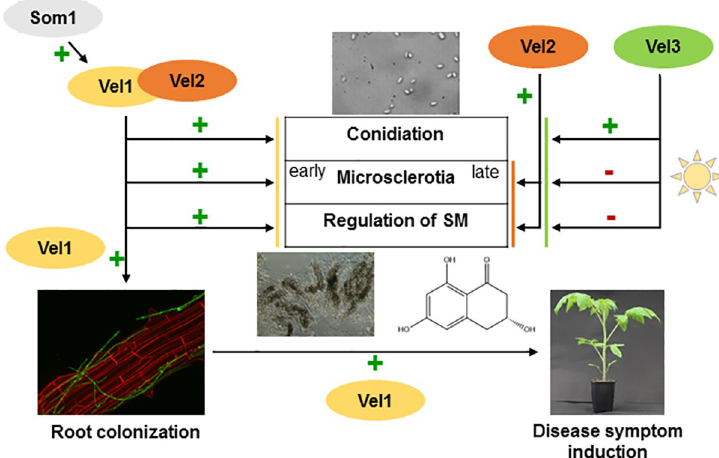
Fig 8. V . dahliae velvet protein functions in development, plant interaction and disease. Vel1 (yellow) forms a heterodimer with Vel2 (orange) during vegetative growth and activates V . dahliae conidiation, microsclerotia formation and a specific secondary metabolism (SM). Vel1 is required for root colonization, penetration and propagation within the host, which requires conidia formation. Som1 (grey) might activate Vel1. Vel2 contributes to a specific SM and is also present during microsclerotia formation when Vel1 is already absent and supports resting structure formation in light. Vel3 (green) reduces Vel1 activated SM as well as microsclerotia formation in light, but activates conidiation (+ indicates supportive functions,—reducing